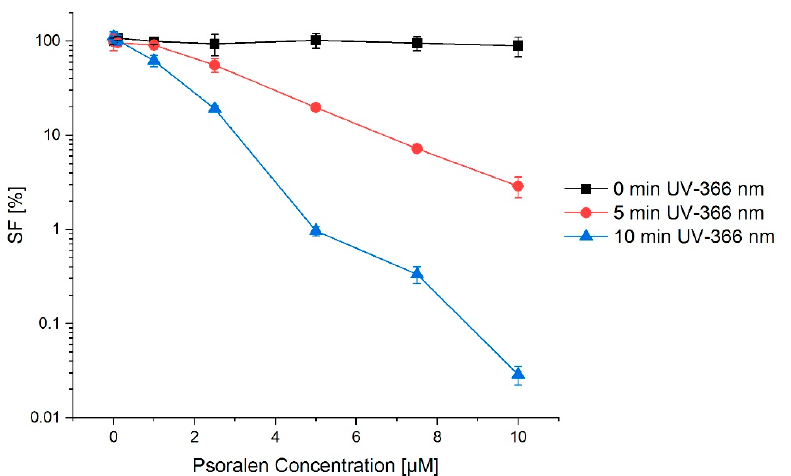
Figure 10. Concentration–effect relation for a combination of psoralen and UV-366 nm (after 24 h preincubation of psoralen in FaDu cells). The longer the irradiation with UV-366 nm, the lower the cell survival fraction (SF). This effect was enhanced by adding psoralen. Without irradiation, there was no difference in survival for any psoralen concentration. The error bars show the SD pooled .